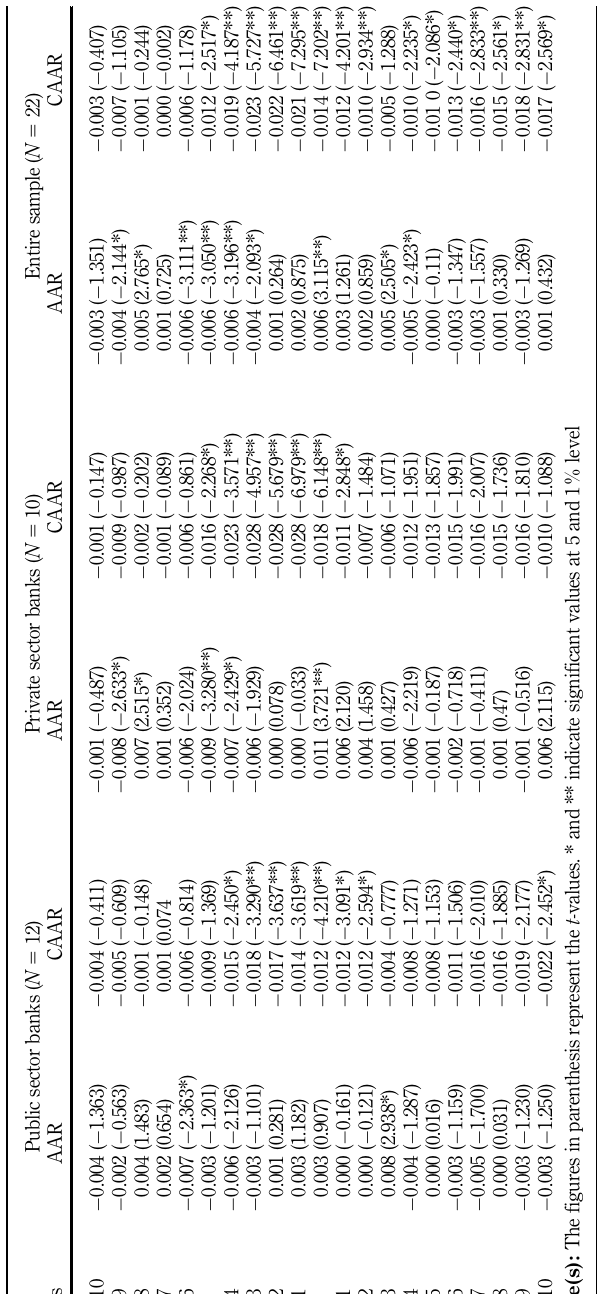
Table 3. Average and cumulative average abnormal returns and corresponding t -values for public sector banks ( N 5 12) and private sector banks ( N 5